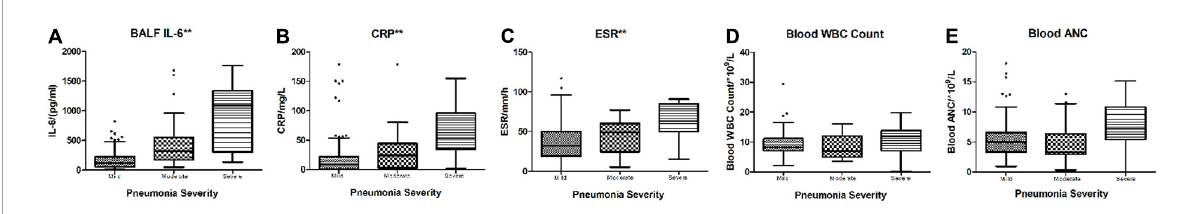
FIGURE1 Boxplot of comparison in BALF IL-6, blood CRP, ESR, WBC count, and ANC across different severity categories. (A) BALF IL-6 ( p = 0.000, < 0.01). (B) CRP ( p = 0.001, < 0.01). (C) ESR ( p = 0.004, < 0.01). (D) Blood WBC count ( p = 0.109, > 0.01). (E) Blood ANC ( p = 0.015, > 0.01). ** p < 0.01.